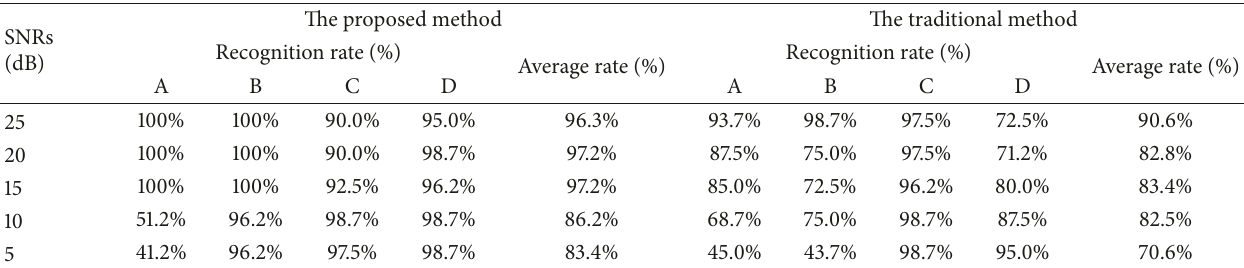
Figure 8: The HMS features are extracted from noise A and noise D. (a) The HMS features using the proposed method. (b) The HMS features using the traditional method. Table 1: Recognition results of real observed signals under different